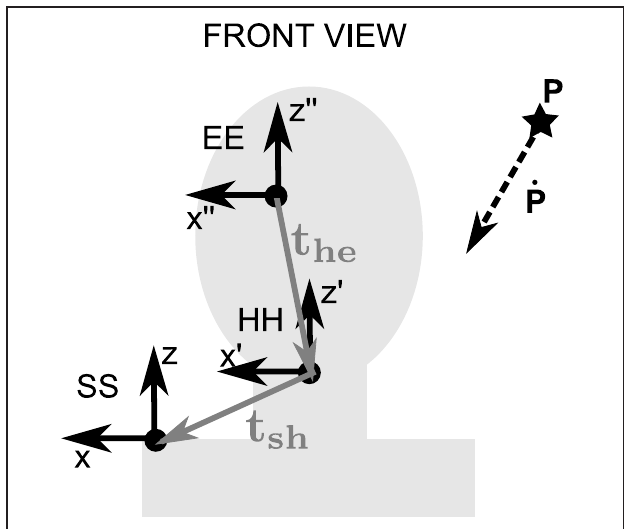
FIGURE 1 | The picture represents a front view of the eye-head-shoulder system. The pointing target position (black star) and velocity (dashed arrow) are represented. These position and velocity can be represented in different reference frames, represented on the figure. These reference frames are: SS (shoulder-centered shoulder-fixed), HH (head-centered head-fixed), and EE (eye-centered eye-fixed). The offsets between the rotation centers are also represented: t he the head position in eye-centered head-fixed coordinates, and t sh the shoulder position in head-centered shoulder-fixed